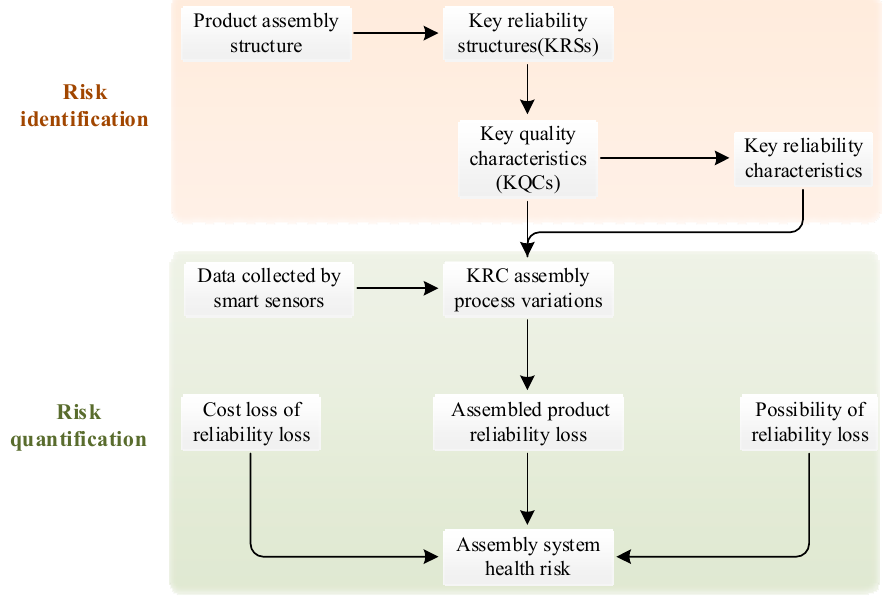
Figure 2. Framework of the health risk assessment model for the product assembly system.